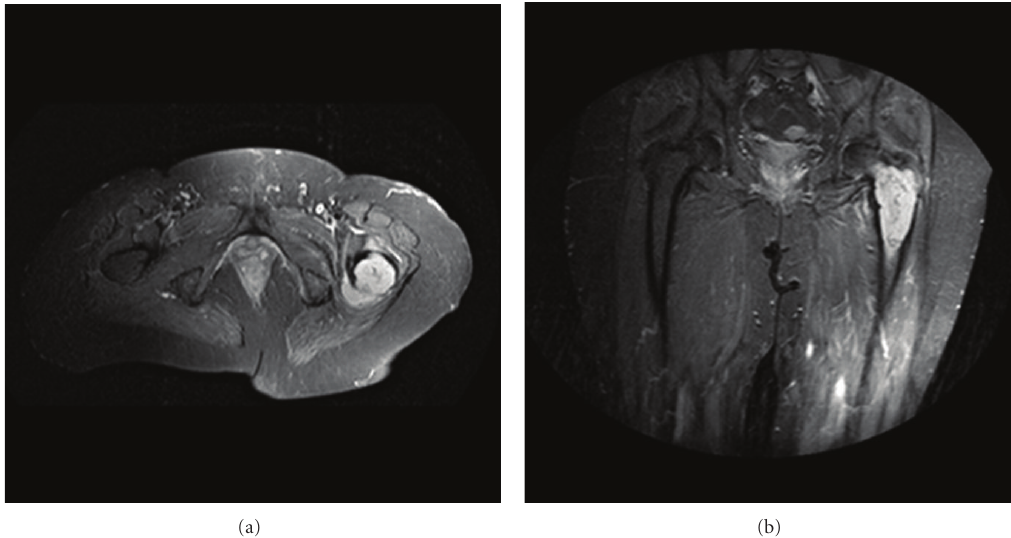
Figure 1: Preoperative MRI showing the left femur of a 76-year-old Caucasian female with diagnosis dedi ff erentiated chondrosarcoma (a) anterior-posterior axial view, (b) anterior-posterior front view.